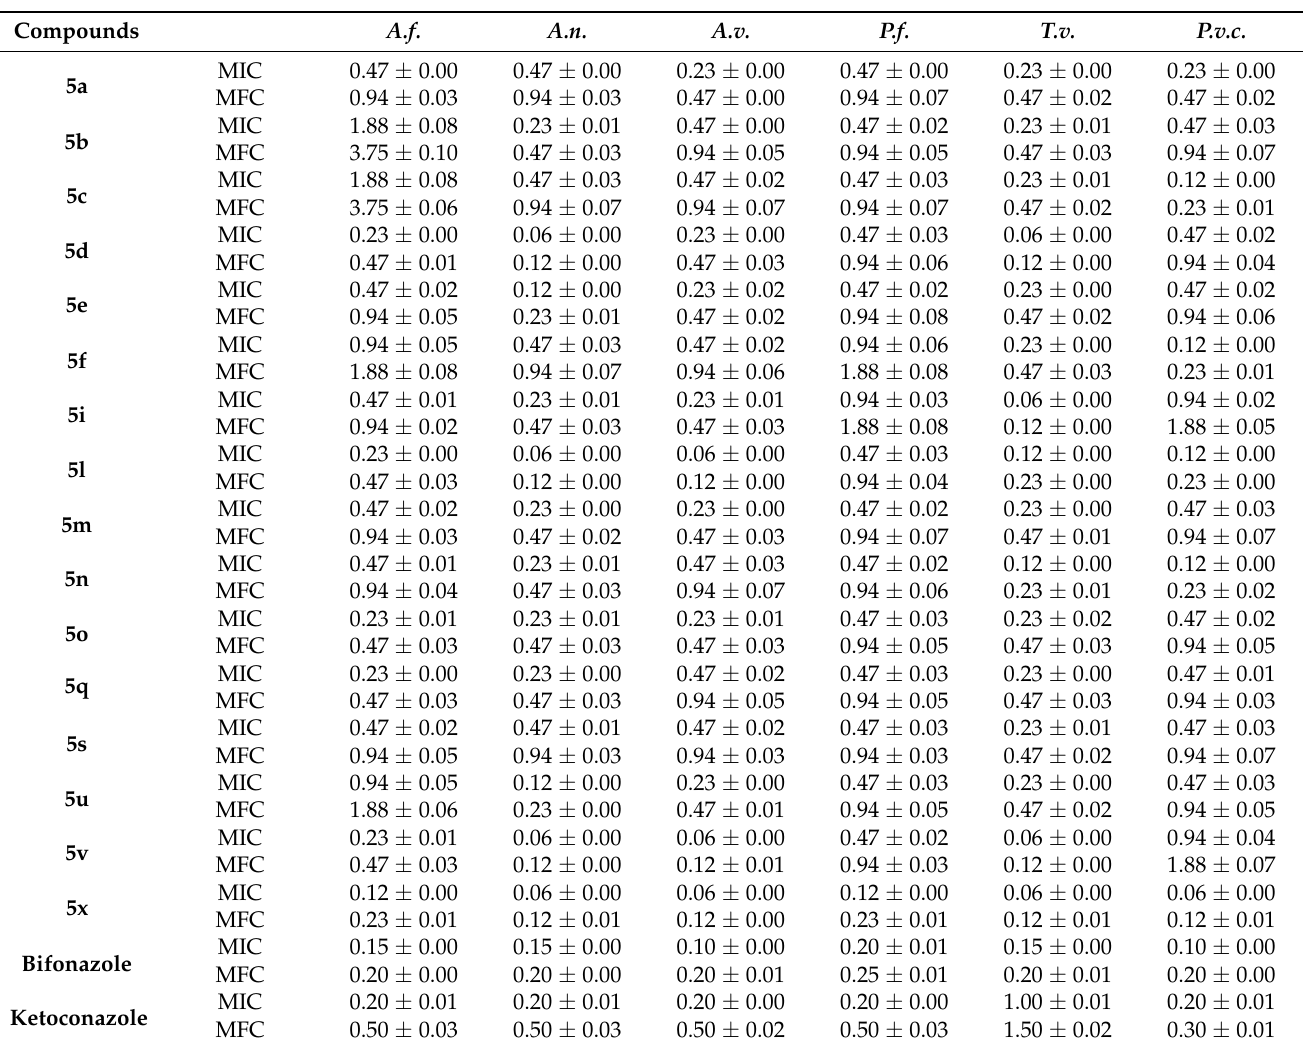
Table 4. Antifungal activity of indole derivatives. (MIC and MBC in